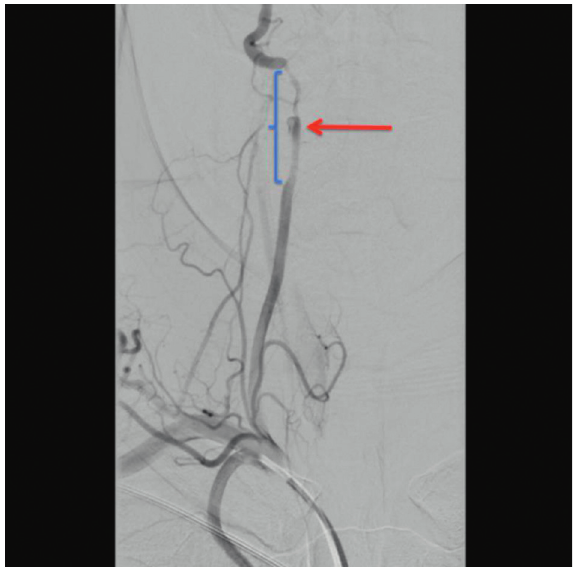
Figure 3: Cerebral angiography showing a dissection flap extending across the C1 loop and to the foramen magnum. Subintimal clot is seen medially in the vessel wall with 50% loss of lumen in the V4 segment. This abrupt change in the caliber of the left vertebral artery shows